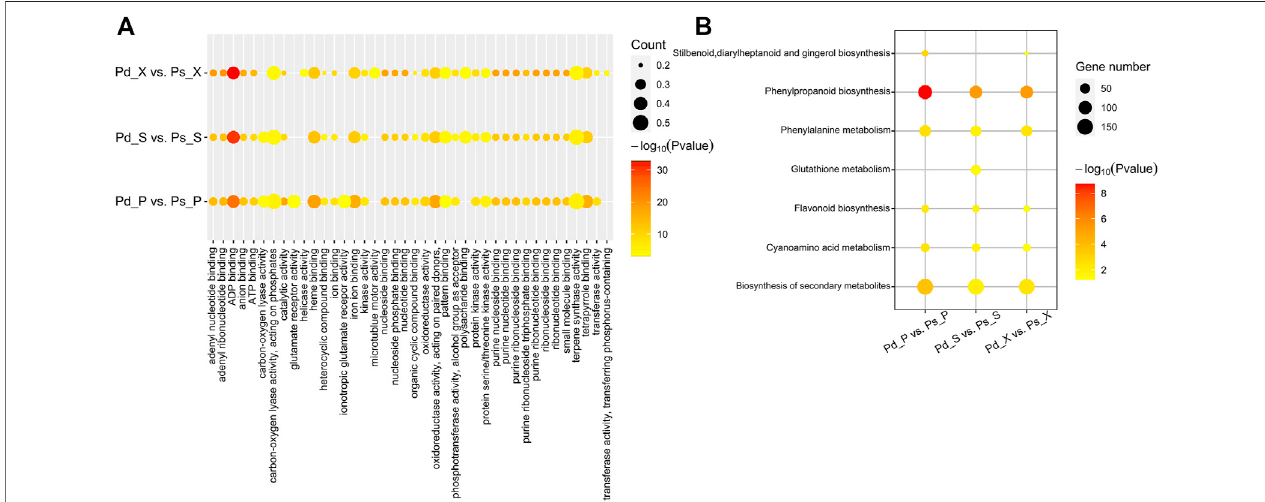
FIGURE 4 | Co-expression mRNA of DElncRANs, GO, and KEGG enrichment. (A) GO enrichment analysis of differentially expressed lncRNA-target genes. (B) KEGG enrichment analysis of differentially expressed lncRNA-target genes. Node color represents − log10 corrected p